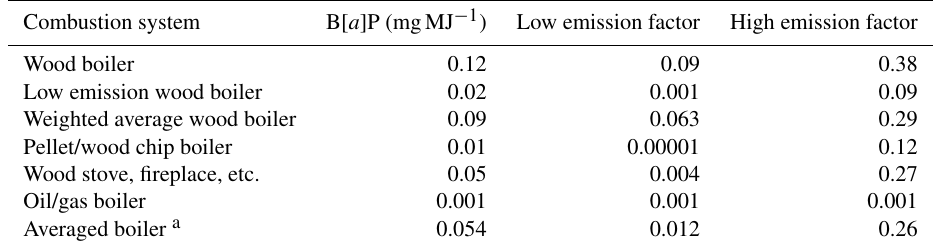
Table A4. B[ a ]P emission factors used in emission inventory in Stockholm County.